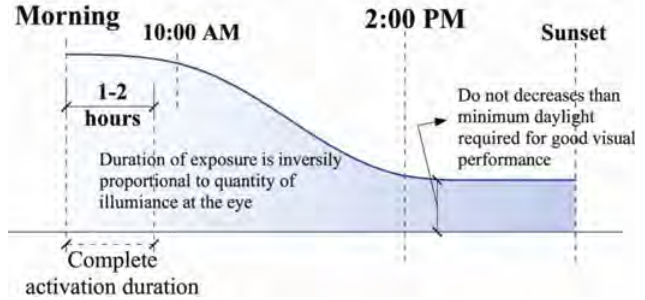
Figure 2. Healthy day-lighting system along the day